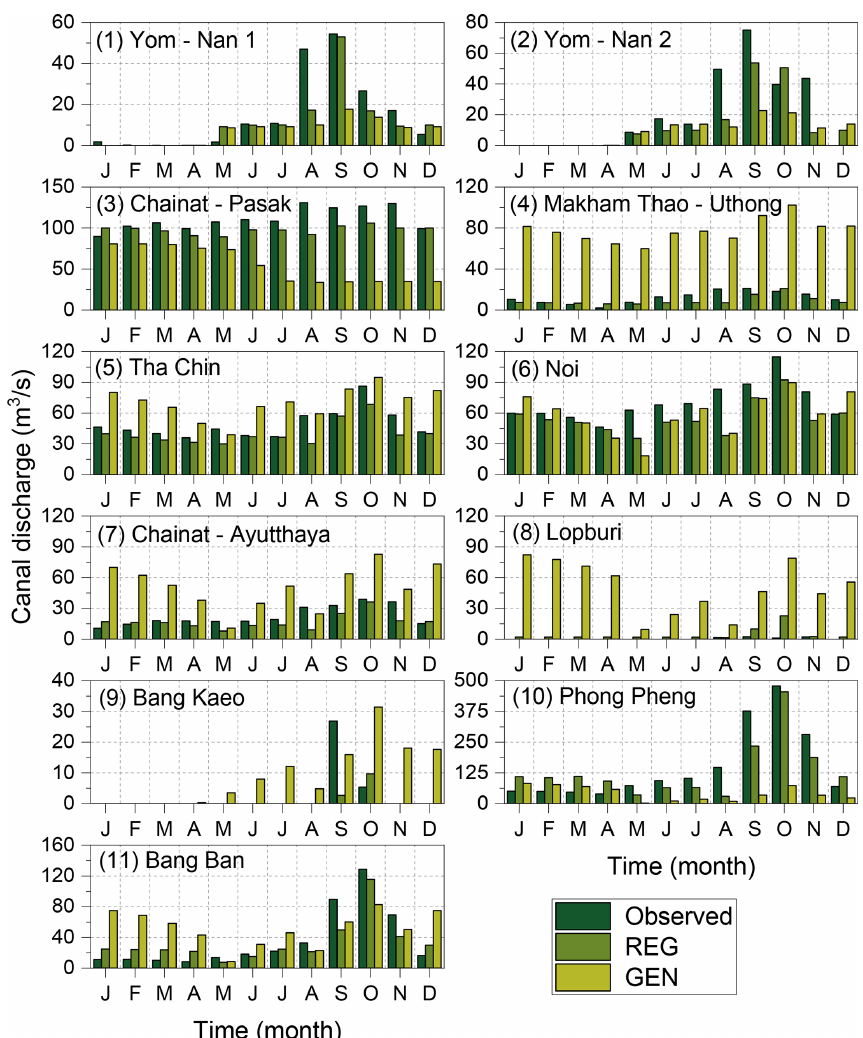
Figure 5. Simulated monthly mean canal discharge (REG and GEN) at 11 canal origins (in the order shown in Fig. 4) compared with the observed